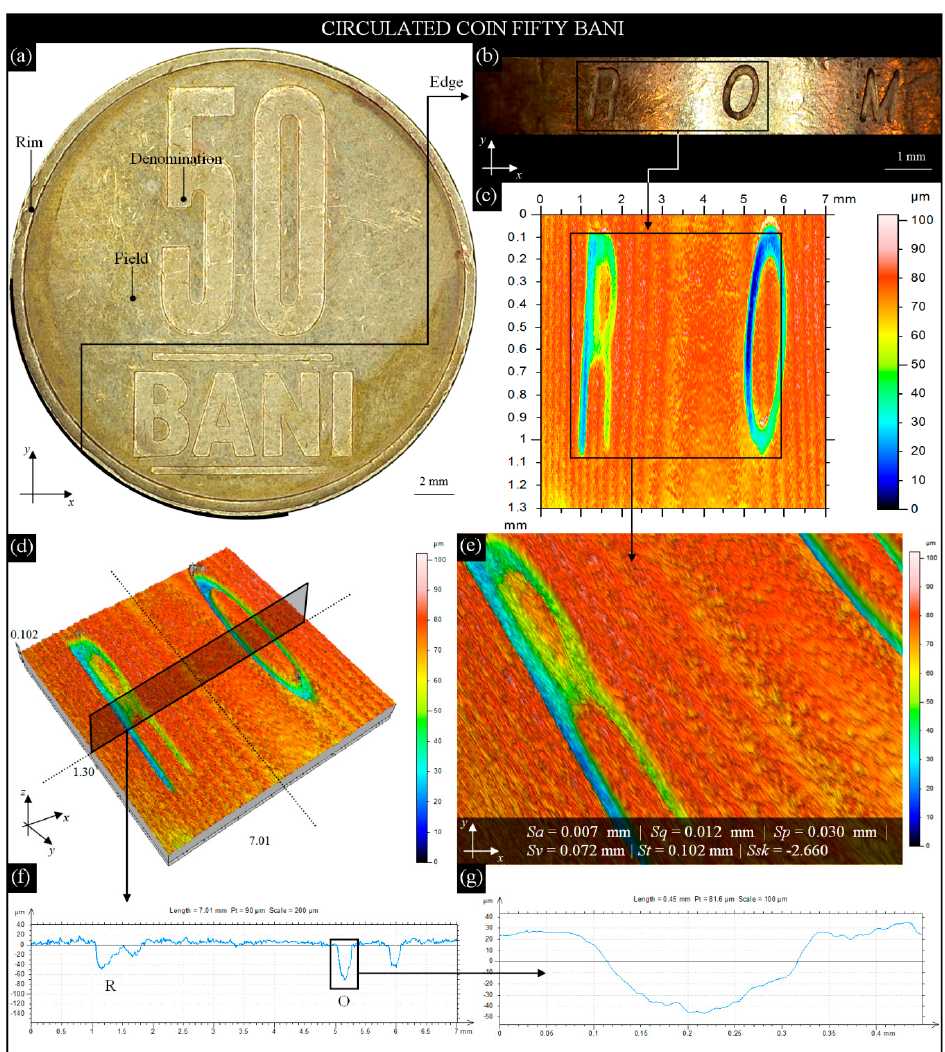
Figure 5. Selected results of observation and analysis of the surface condition of modern Romanian circulated 50 bani coin obtained by the digital microscope Omni Core (Ash Technologies Ltd., Kildare, Ireland) and 3D optical profilometer S neox (Sensofar Metrology, Terrassa, Spain): ( a ) general view of coin reverse; ( b ) image (11.42 × 1.90 mm) of a fragment of the coin’s smooth and lettered edge; ( c ) 2D height map (indexed colors) of the AOI (7.01 × 1.30 mm) from Figure 4b; ( d ) surface microtopography (7.01 × 1.30 × 0.10 mm); ( e ) close-up view (5.10 × 1.00 mm) of the smooth and lettered edge with calculated amplitude (surface) parameters; ( f ) extracted from Figure 4d, a single surface profile with deformed left side of the letter O; ( g ) extracted from Figure 5f and enlarged letter O.